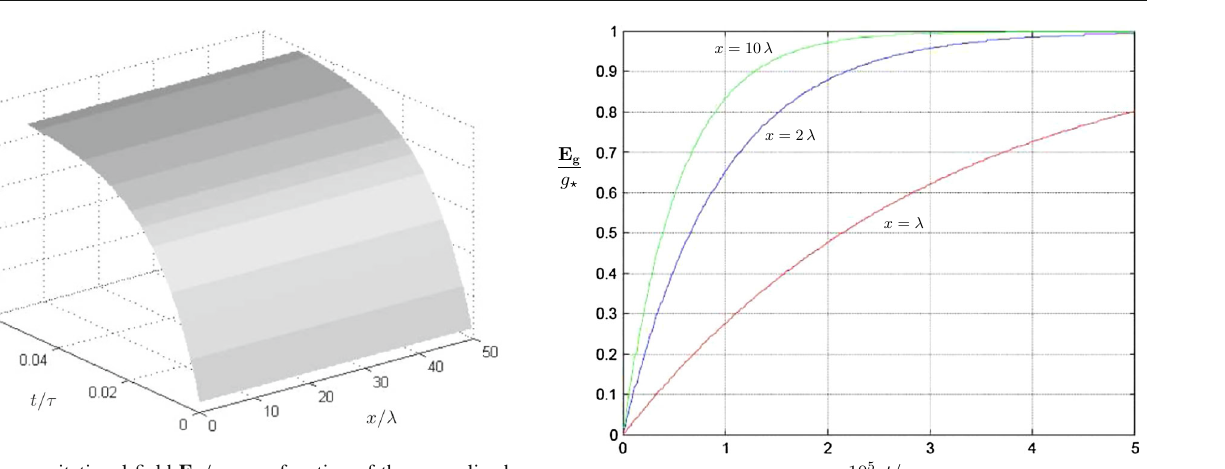
Fig. 1 The gravitational field E g / g (cid:23) as a function of the normalized time and space for YBCO at T = 77K